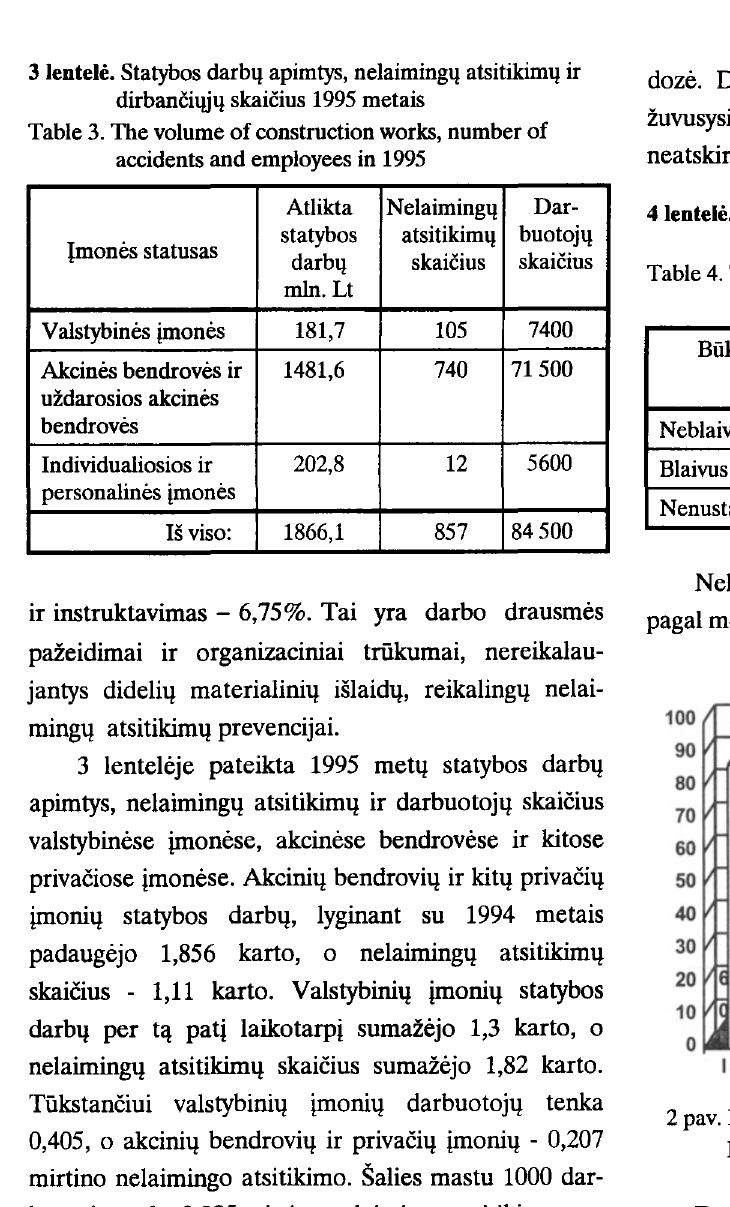
Table 4. The distribution of accidents with respect to soberness in 1995 Bukle